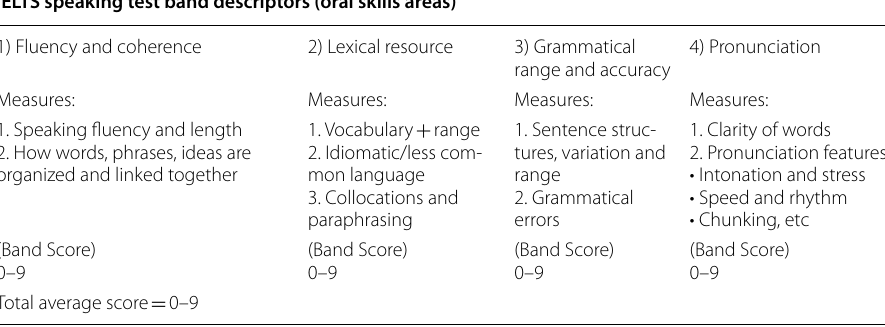
IELTS speaking test band descriptors (oral skills